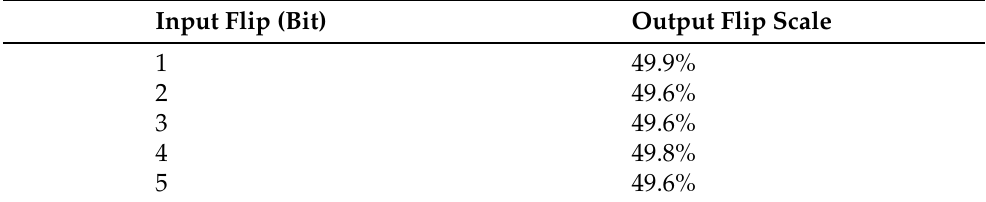
Table 6. Avalanche effect